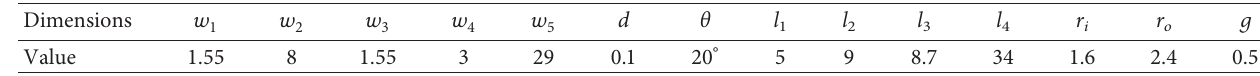
Figure 1: Geometry of the proposed antenna. (a) Top and (b) bottom. Table 1: The structure parameters of antenna (units: